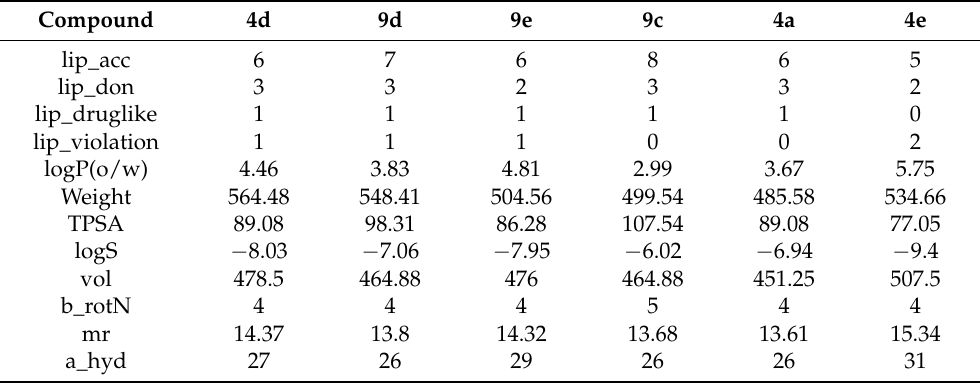
Table 8. Results of Lipinski and Veber rules for the tested